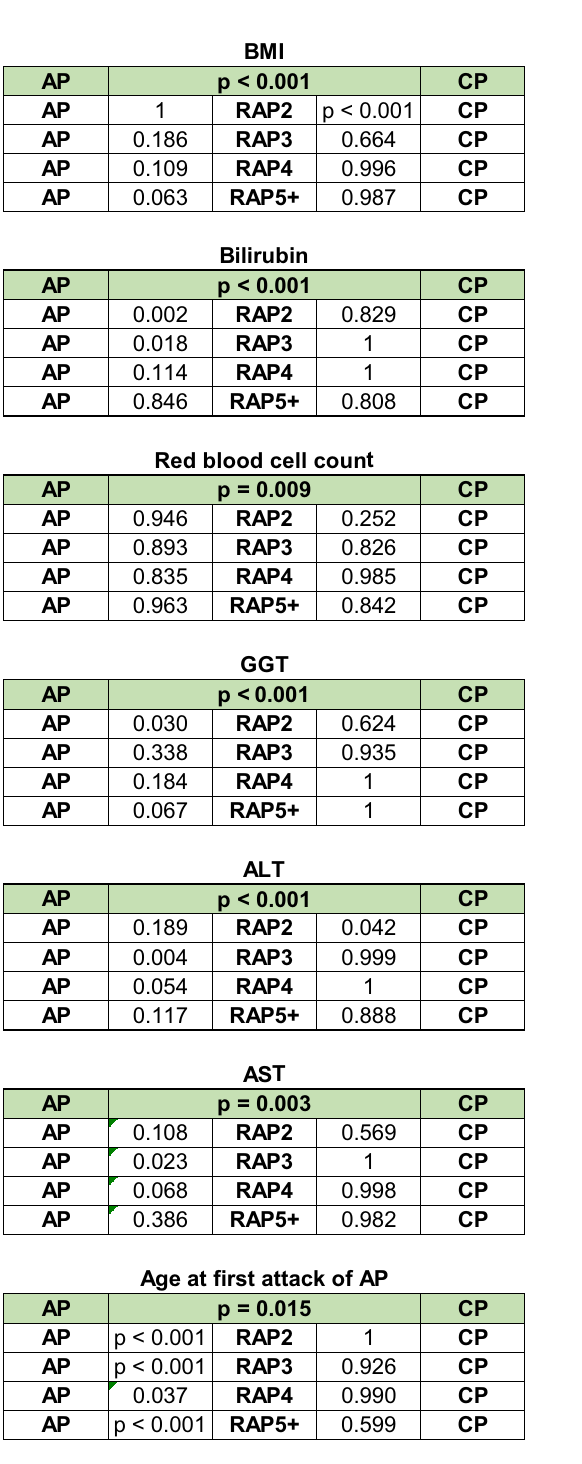
Figure 4. Significant differences between thirteen